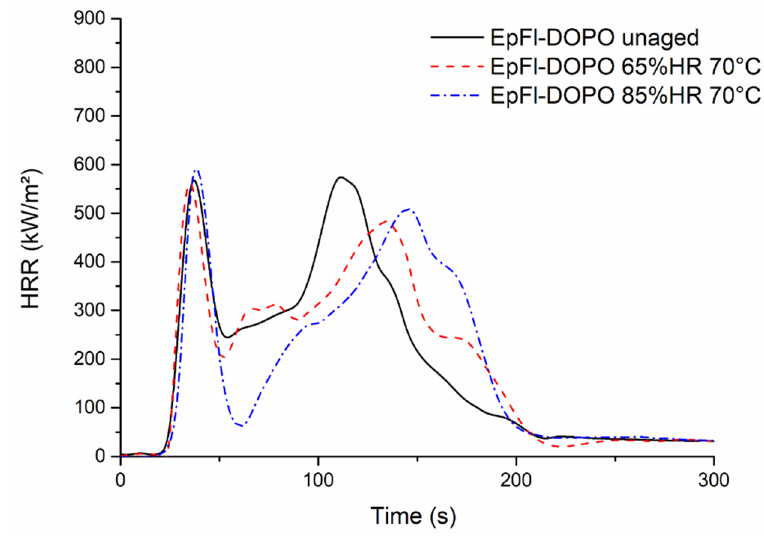
Figure 14. Cone calorimeter curves of EpFl-DOPO aged at 70 °C in different conditions.